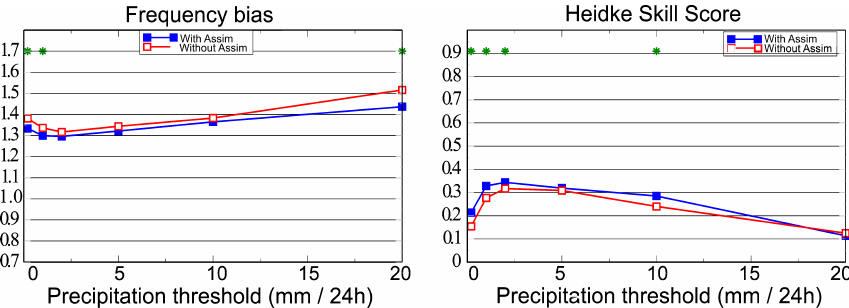
Fig. 9. Twenty-four hour accumulated precipitation forecast scores (Bias and Heidke Skill score) obtained with (blue curves) and without (red curves) soil analysis by the AROME model over a three week period (21 April 2010–15 May 2011). A green star indicates that the score difference is significant with a 90% confidence level.